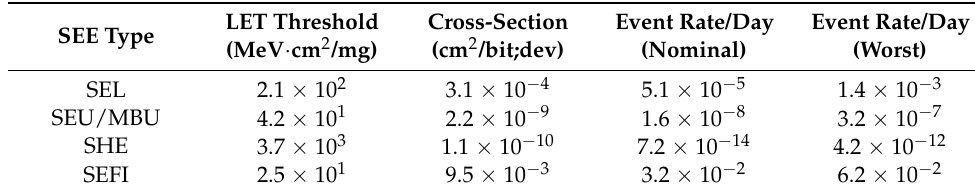
Table 8. Predicted in-orbit rates for different types of SEEs based on the radiation test data and their